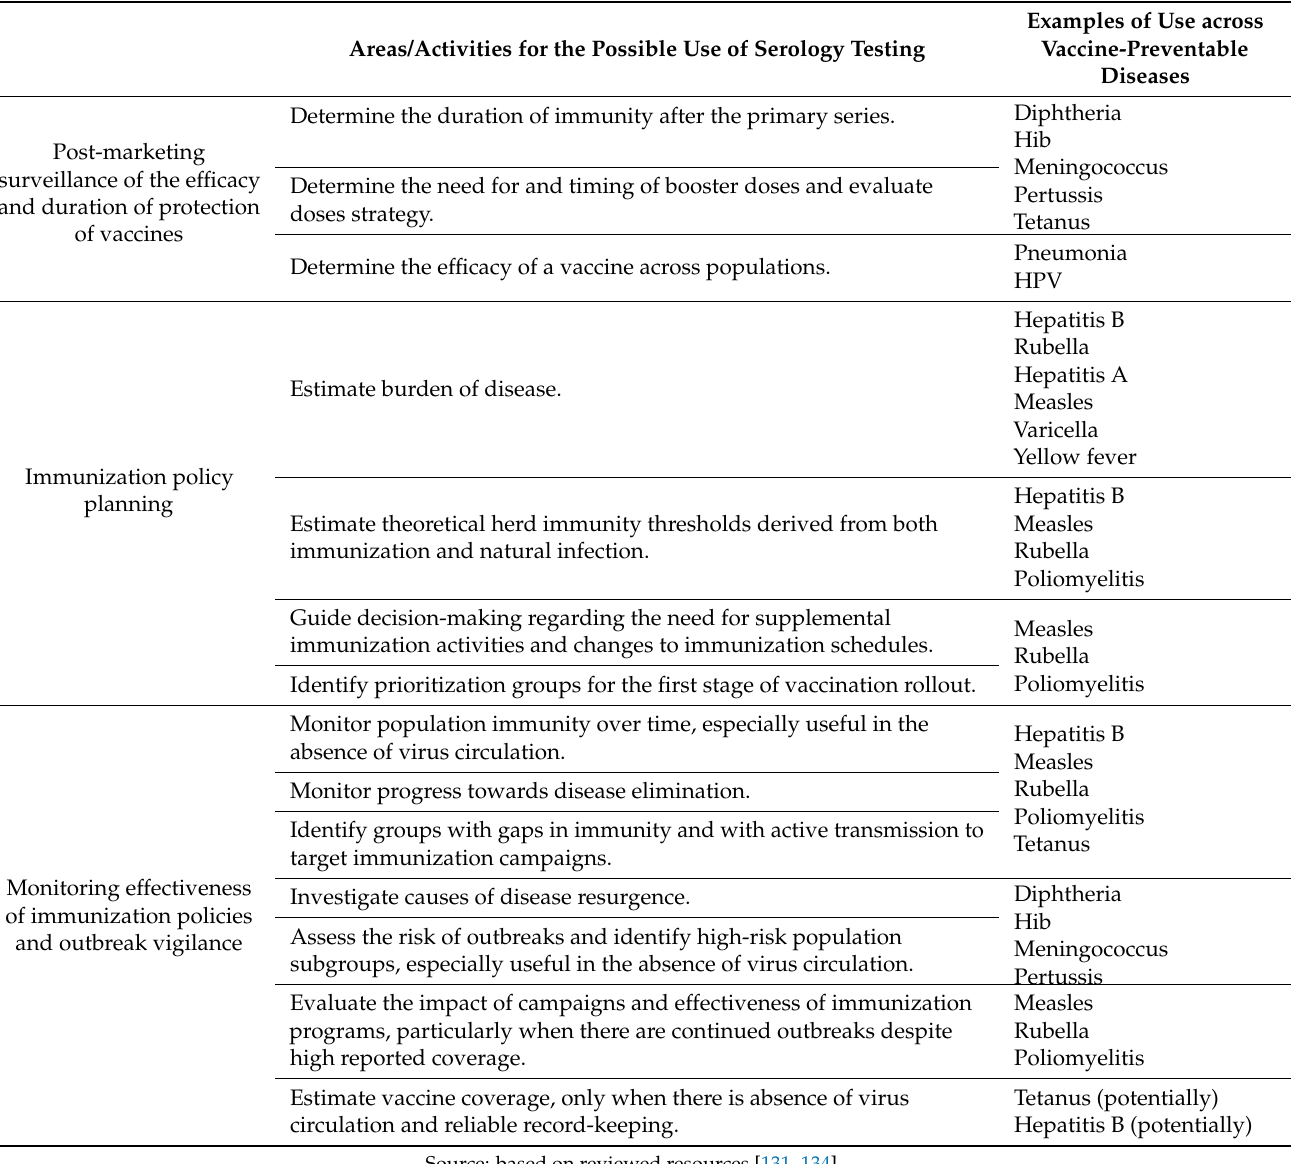
Table 3. Potential areas where using serology testing can support immunization activities.